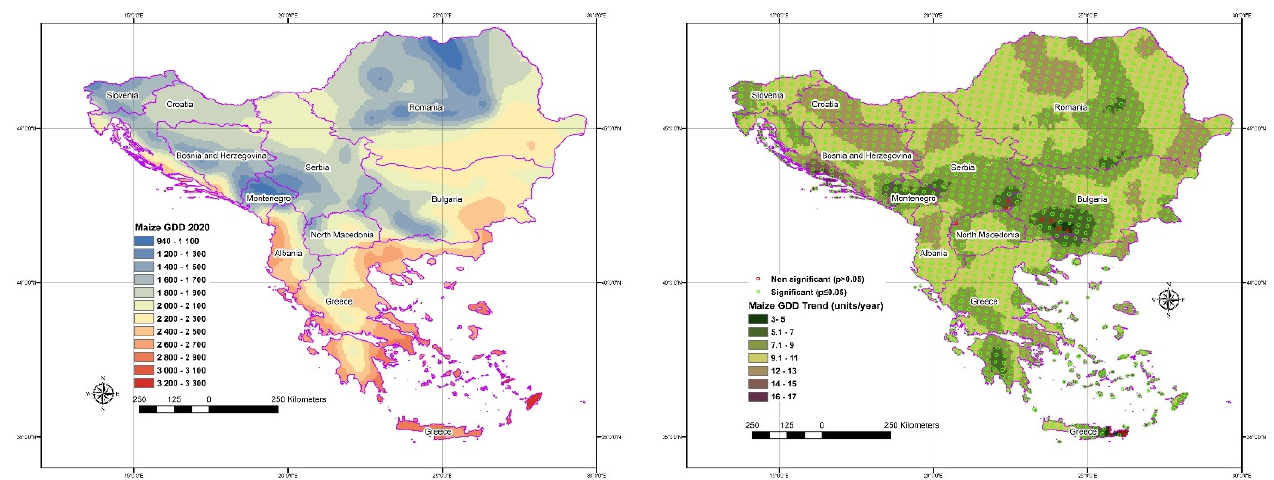
Figure 2. The GDD spatial distribution for the maize cultivation in 2020 ( left ) and the GDD trend with statistical significance marks ( right ).